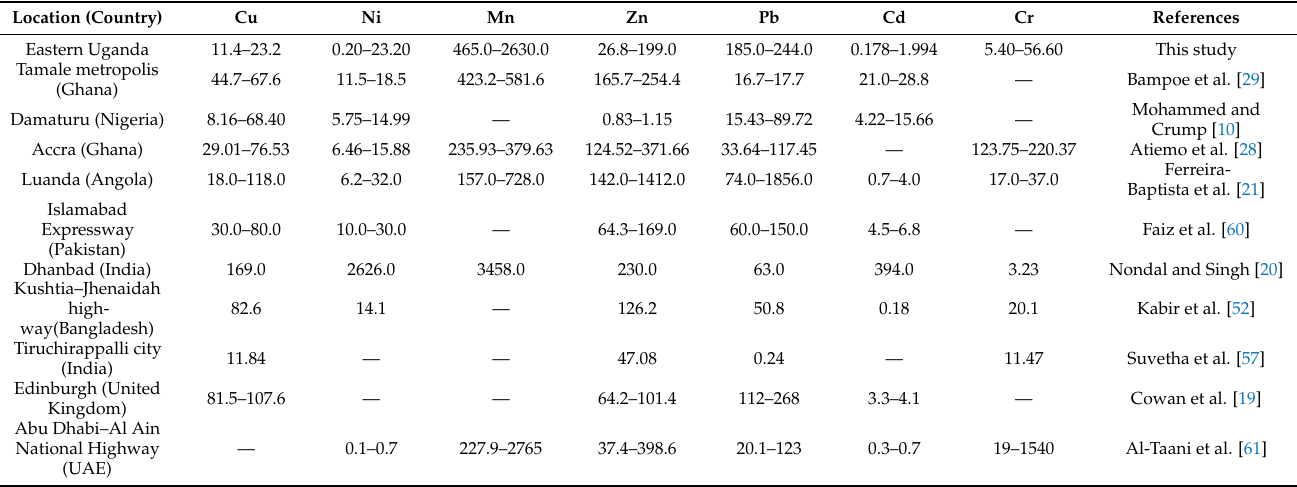
Table 2. Comparison of PTE concentrations (mg kg − 1 ) in dust from urban roads, highways and pedestrian bridges in Eastern Uganda with previous